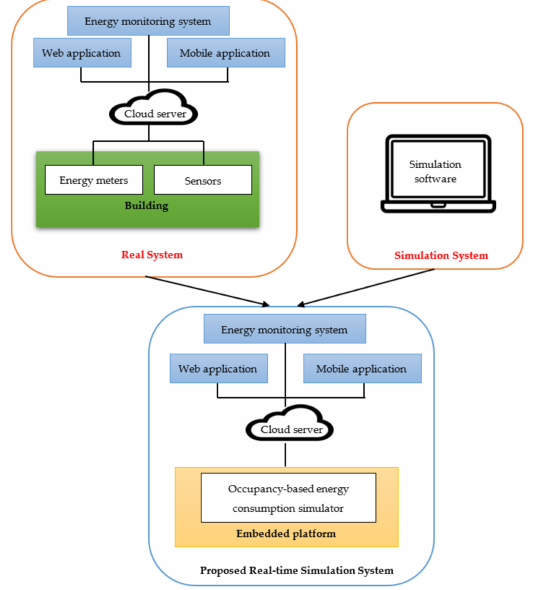
Figure 1. Proposed real-time simulation